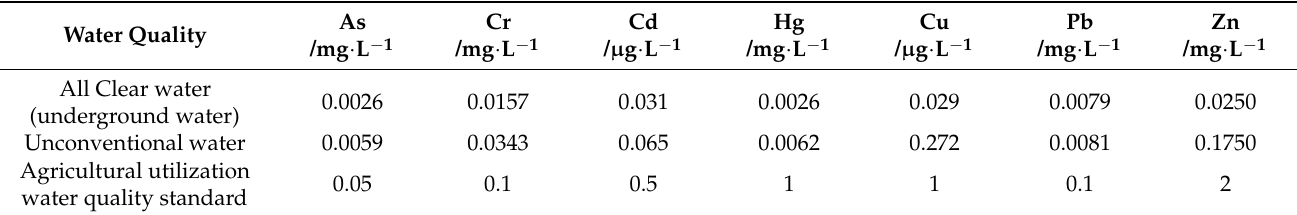
Table 1. Heavy metals in the unconventional water of black soil irrigation area around the metallic